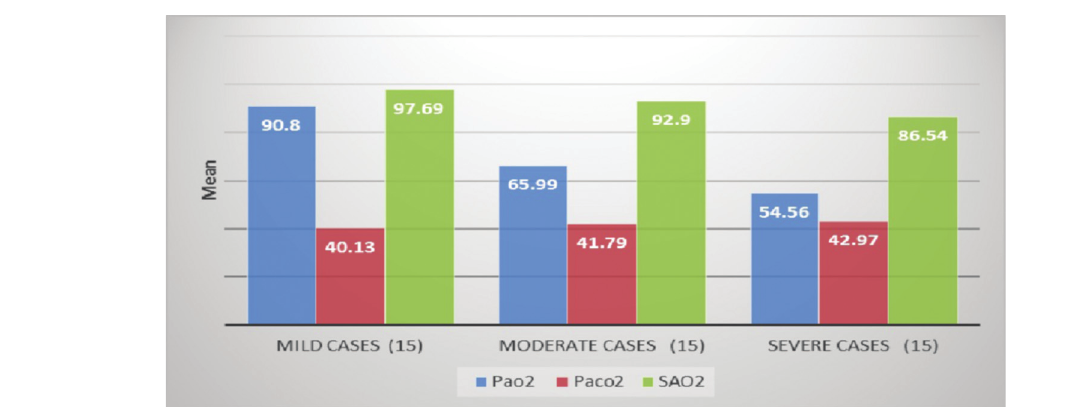
Comparison between the studied groups according to PaO 2 , PaCO 2 , and SaO 2 . PaCO 2 , partial pressure of carbon dioxide in arterial blood; PaO 2 , partial pressure of oxygen in arterial blood; SaO 2 , oxygen saturation.